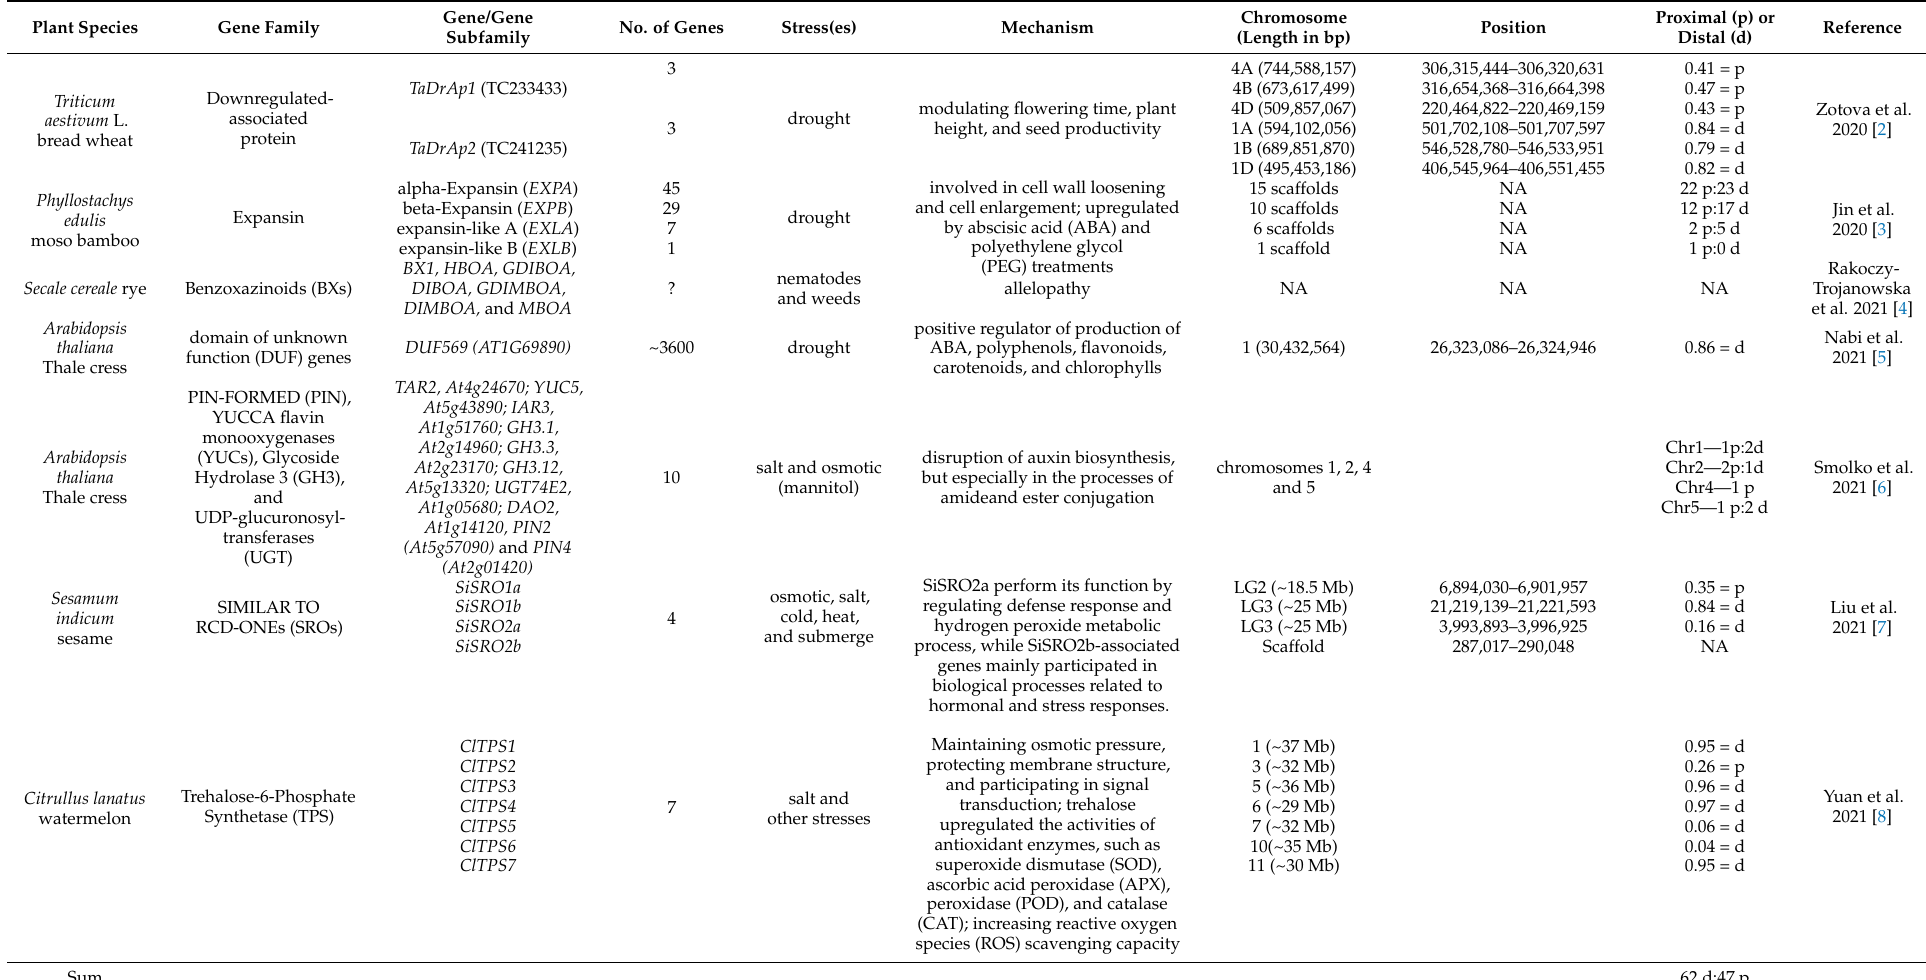
Table 1. Research articles on gene families associated with tolerance to abiotic stresses in this Special Issue on mapping genes to